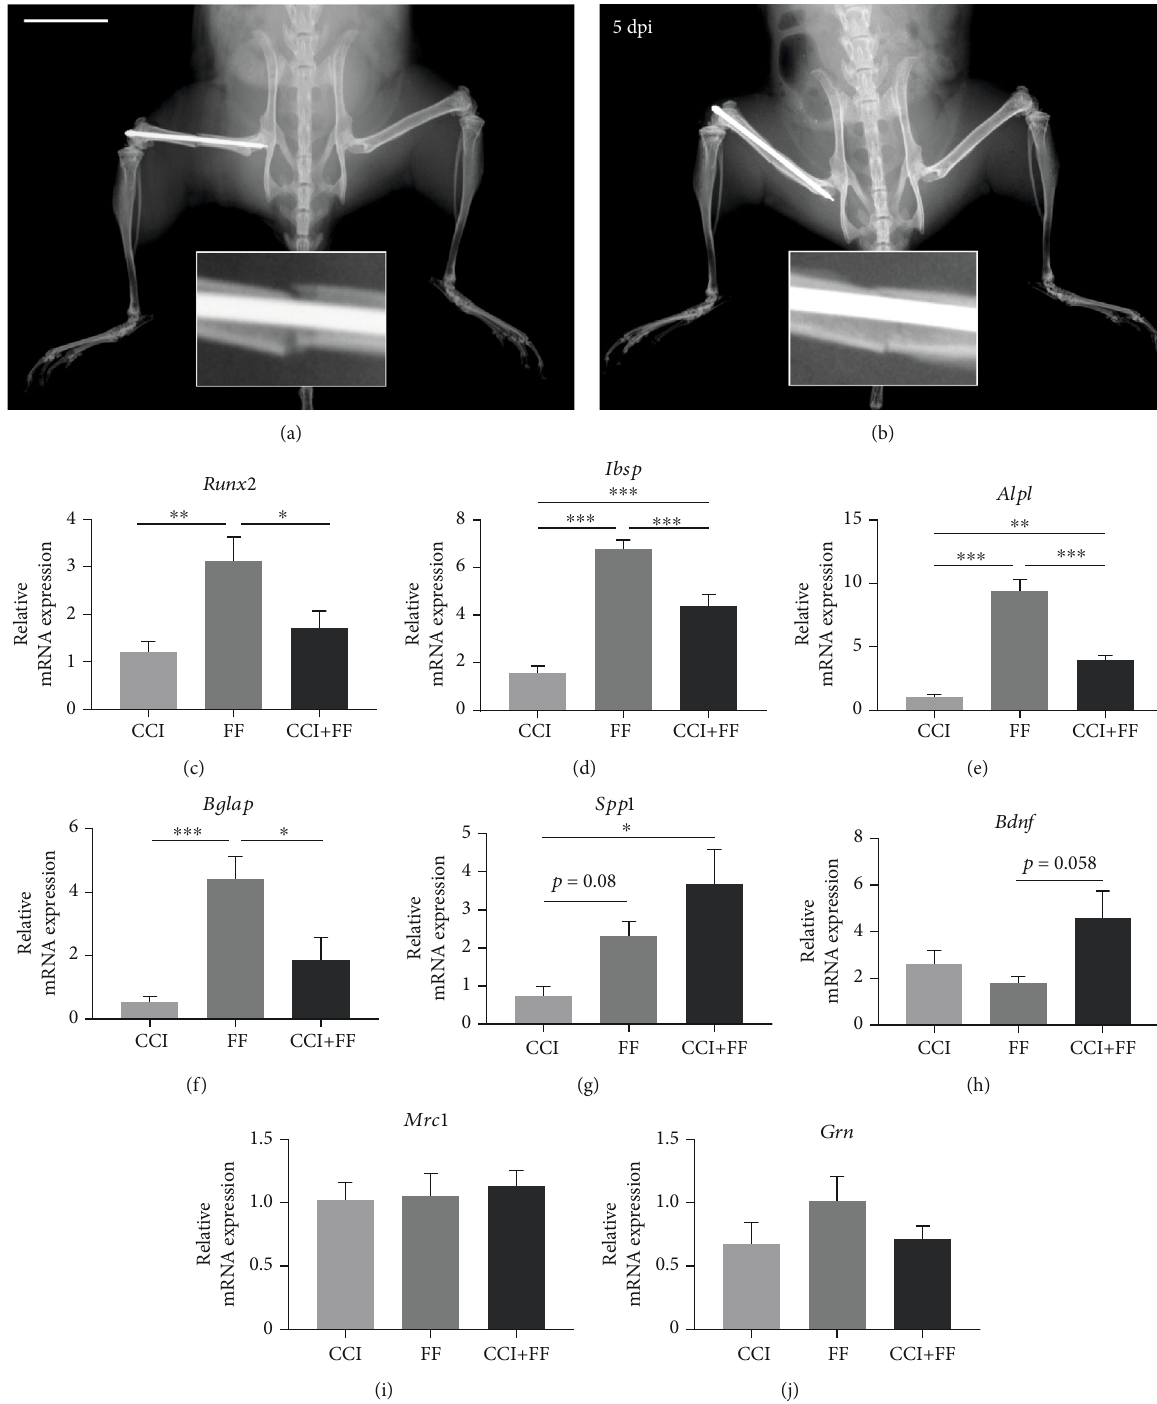
Figure 5: Concomitant TBI alters gene expression in the fractured femur. Representative X-ray images of the osteosynthetic stabilized femoral fracture during (a) surgical procedure and (b) 5 dpi post mortem , fracture gaps are enlarged for detailed view. Scale bar: 1 cm. (c – j) Gene expression analyses in the perifractural bone tissue normalized to GAPDH and to sham 5dpi ( n = 7 /group). Gene expression of Runx2 ( Runx2 , c), bone sialoprotein ( Ibsp , d), alkaline phosphatase protein ( Alpl , e), and osteocalcin ( Bglap , f) was increased in fractured bones of the FF group compared to uninjured femora of the isolated CCI group, but signi fi cantly reduced by the additional CCI in CCI +FF mice. Gene expression of osteopontin ( Spp1 , g) was increased in CCI+FF mice compared to sham. Gene expression of BDNF ( Bdnf , h) was increased in CCI+FF compared to isolated CCI but the di ff erences failed statistical signi fi cance ( p = 0 : 058 ). No signi fi cant di ff erences were revealed for the gene expressions of MRC1 ( Mrc1 , i) and progranulin ( Grn , j). Values represent mean ± SEM ; p values were calculated by Holm-Sidak ’ s multiple comparison